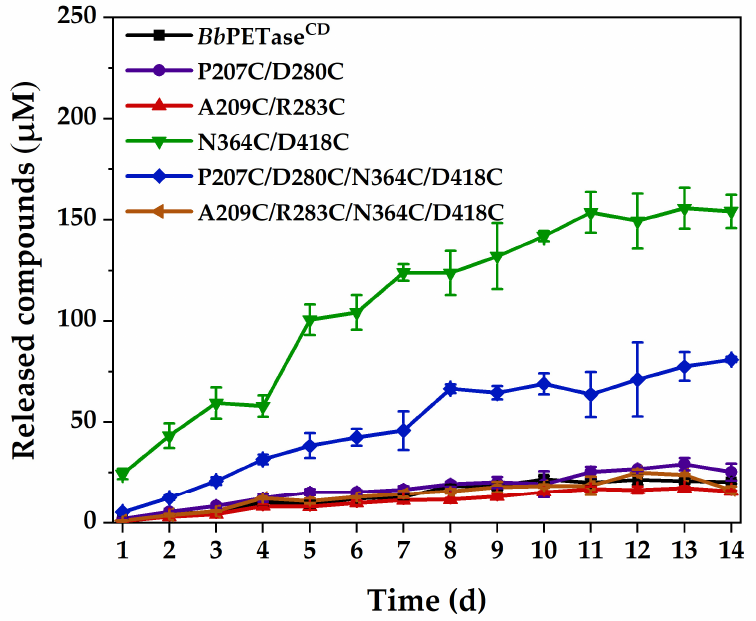
Figure 4. Hydrolytic activity of Bb PETase CD and its variants on PET fi lms at 40 °C. The fi nal concentration of the enzyme was 200 nM. Two PET fi lms of 6 mm diameter were placed in each reaction centrifuge tube as substrates.